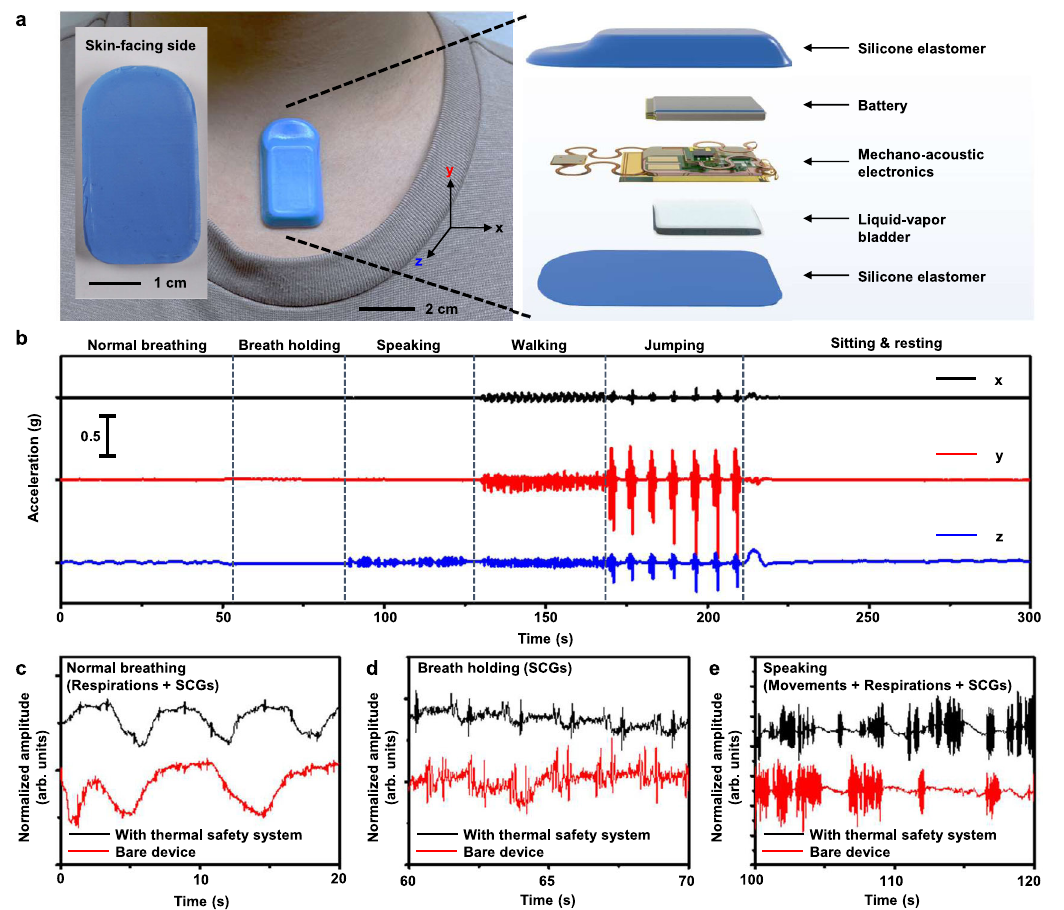
Fig. 4 | Operation of a skin-interfaced, wireless mechano-acoustic (MA) sensor with an integrated thermal safety system. a Photographs and an exploded schematic illustration of the MA device with a liquid – vapor bladder. The inset is a photograph of the skin-facing side of the device. b Three-axis accelerometry recorded with the device over 300s during various activities, including normal